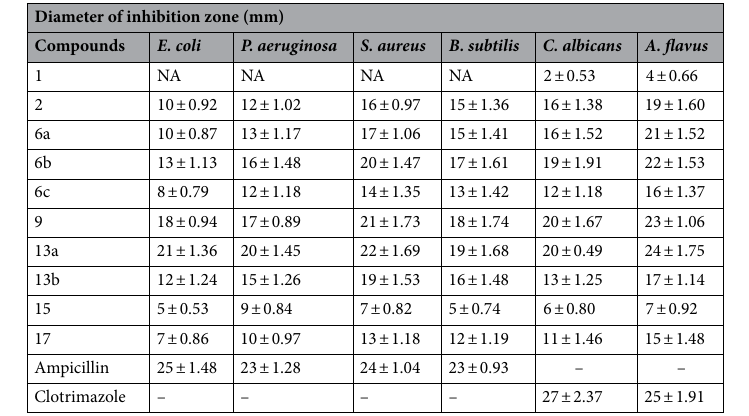
Table 2. In vitro antimicrobial activity of the synthesized compounds a,b . a Antimicrobial activity expressed as inhibition diameter zones in millimeters (mm) of synthesized compounds against the pathological strains based on well diffusion assay. b The experiment was carried out in triplicate and the average zone of inhibition was calculated. c NA No activity.